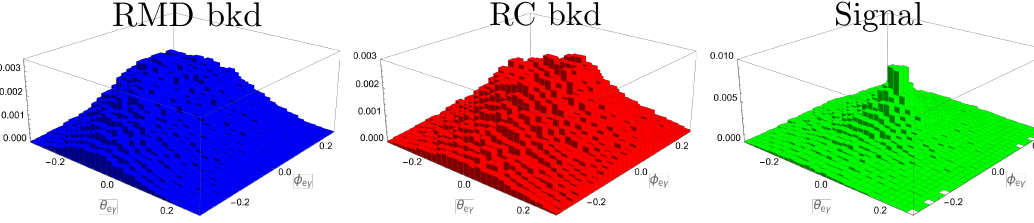
Figure 7 . The unit-normalized distributions of RMD (Left), RC (Middle) background and signal (Right) events on the ( θ eγ , φ eγ )-plane for the parasitic analysis ( • in figure 1) with the bin size of 20mrad ( θ eγ ) × 20mrad ( φ eγ ). For the signal we took m a = 10 − 4